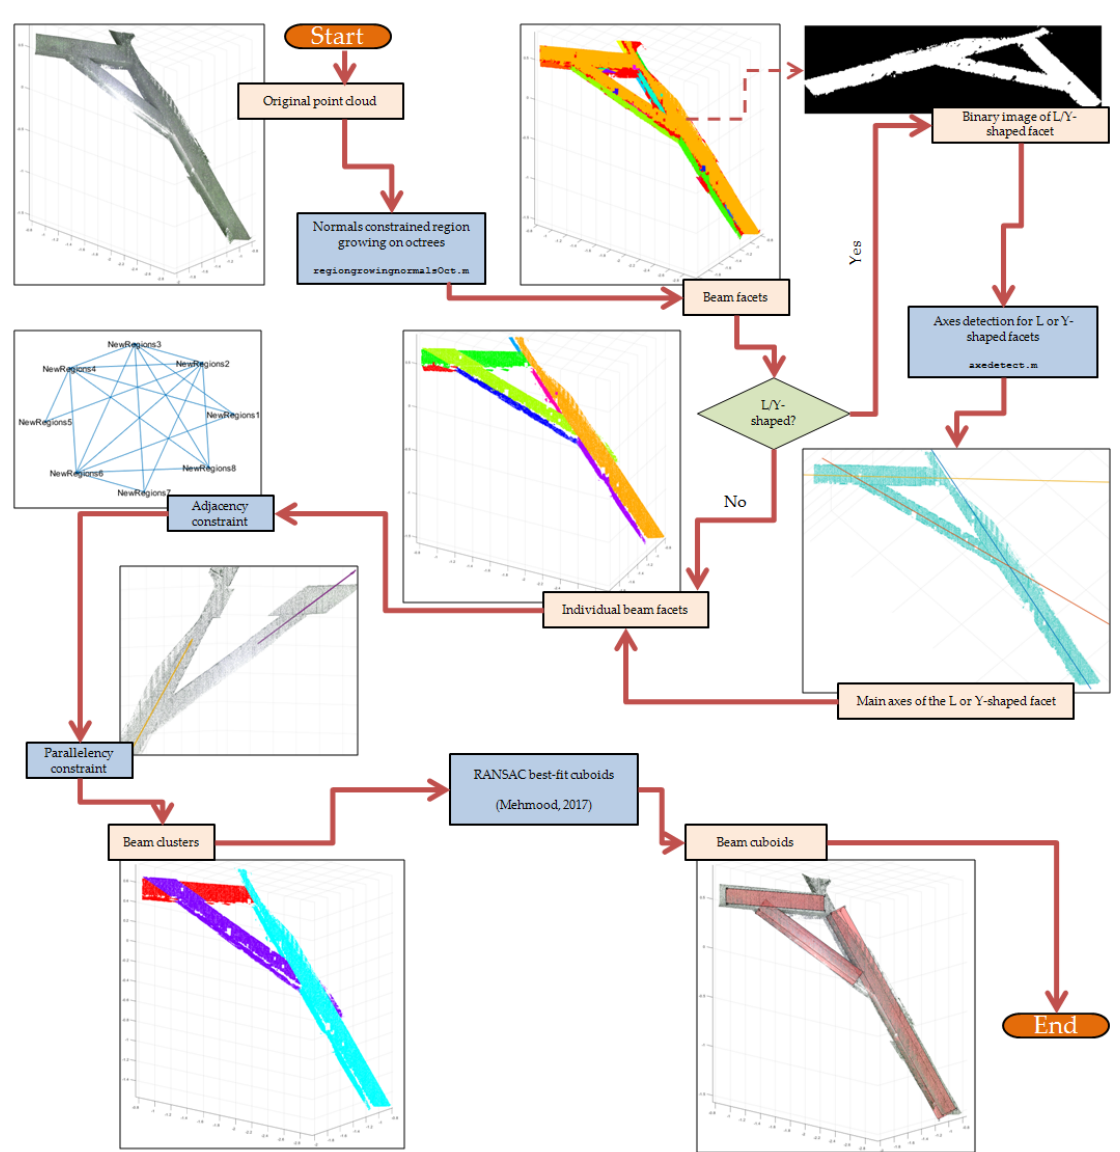
Figure 12. A flowchart of the main steps in the beamdetect.m function of M_HERACLES showing the intermediate and final